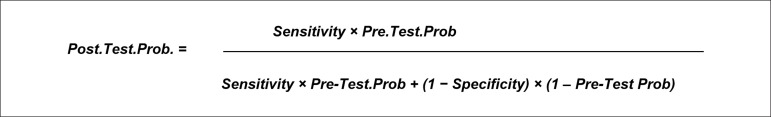
Formula for calculating post-test probability of a disease according to Bayes’ theorem.